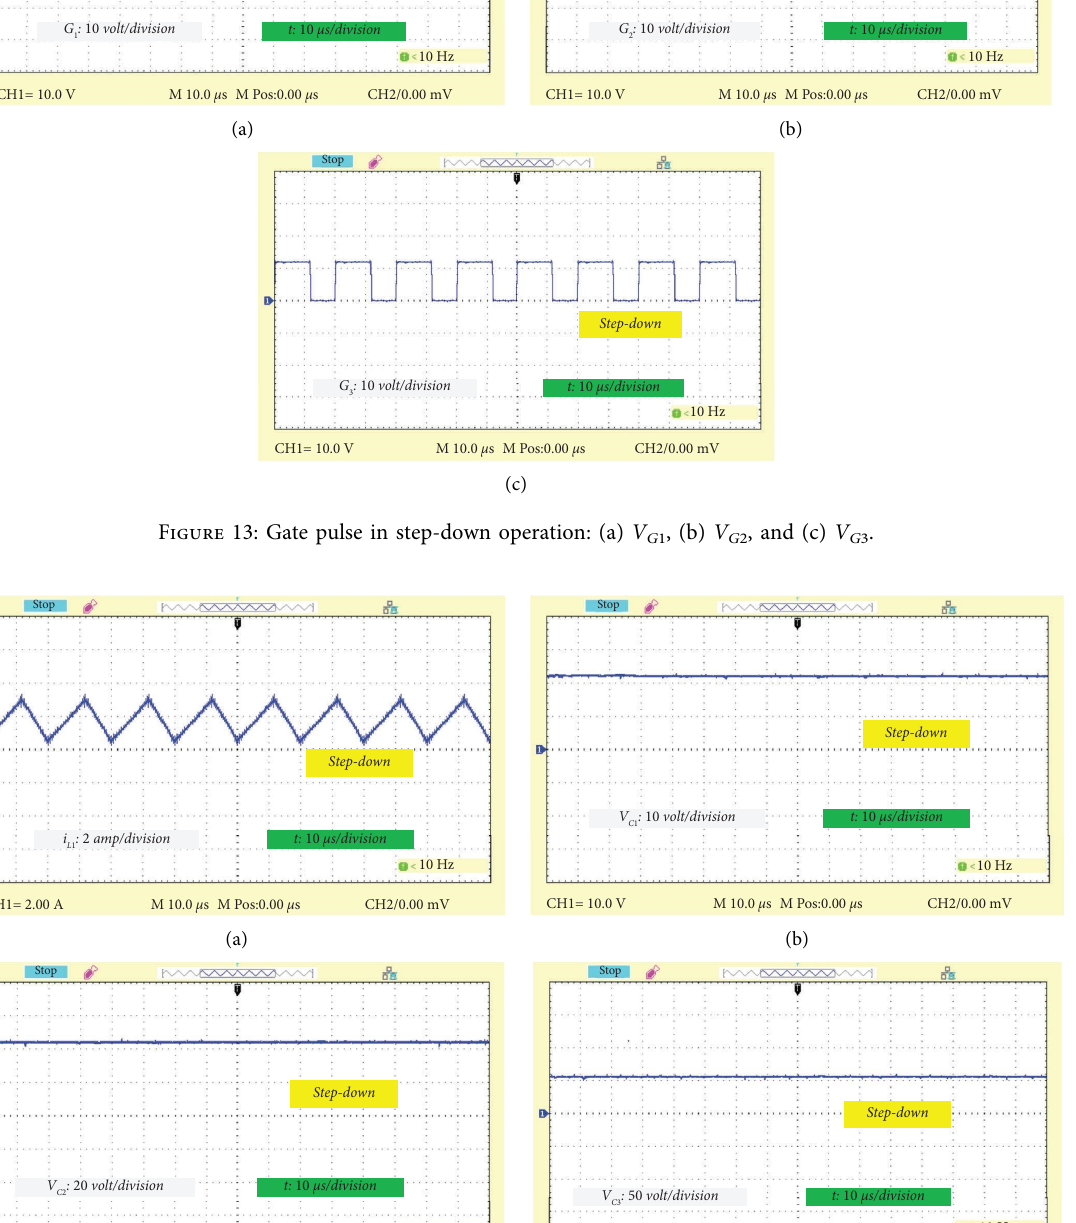
L 1 , (b) V C 1 , (c) V C 2 , and (d) V C 3